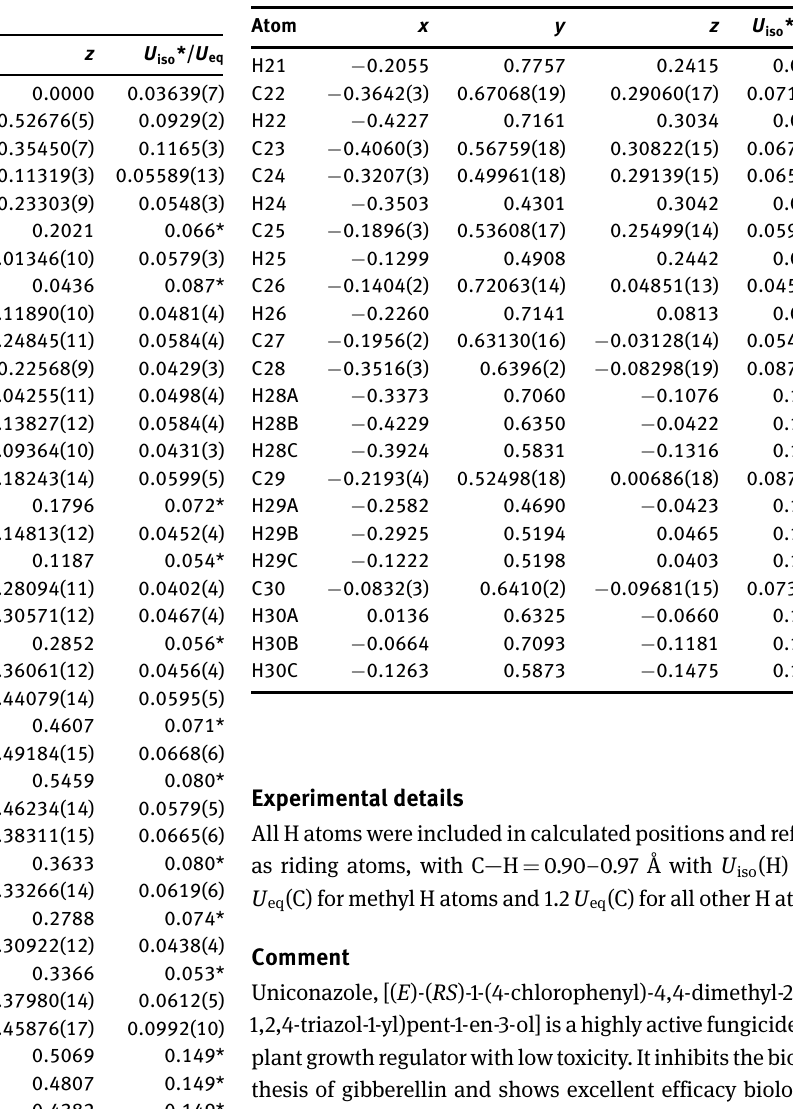
Table 2: Fractional atomic coordinates and isotropic or equivalent isotropic displacement parameters (Å 2